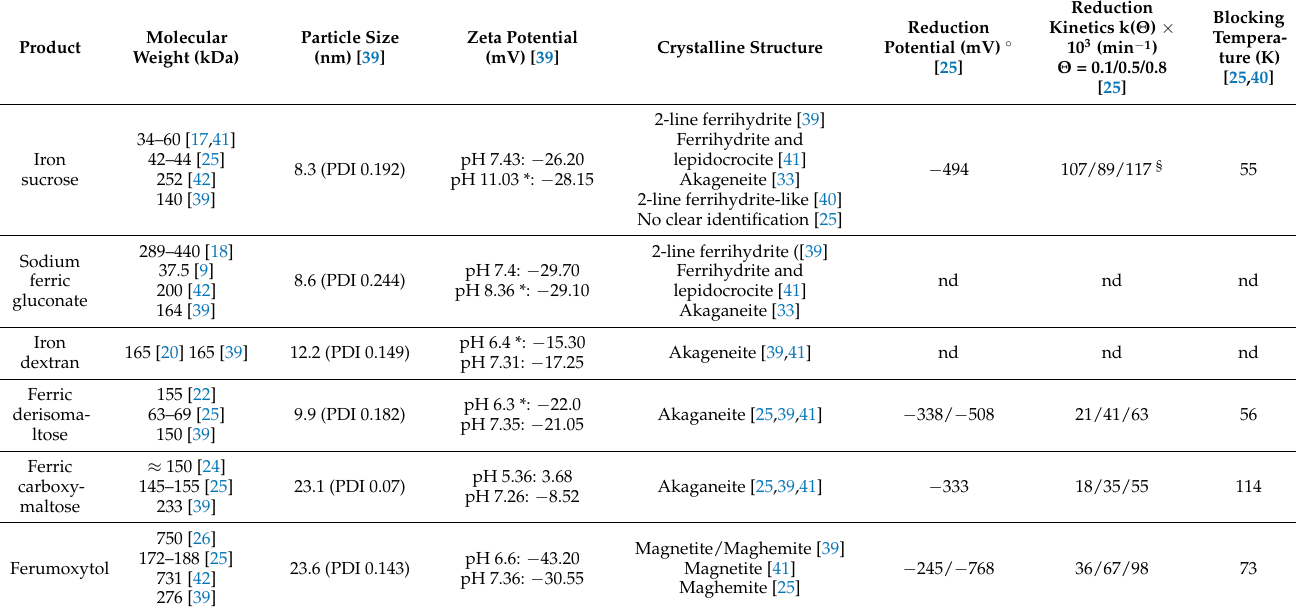
Table 4. Physico-chemical properties of iron carbohydrate